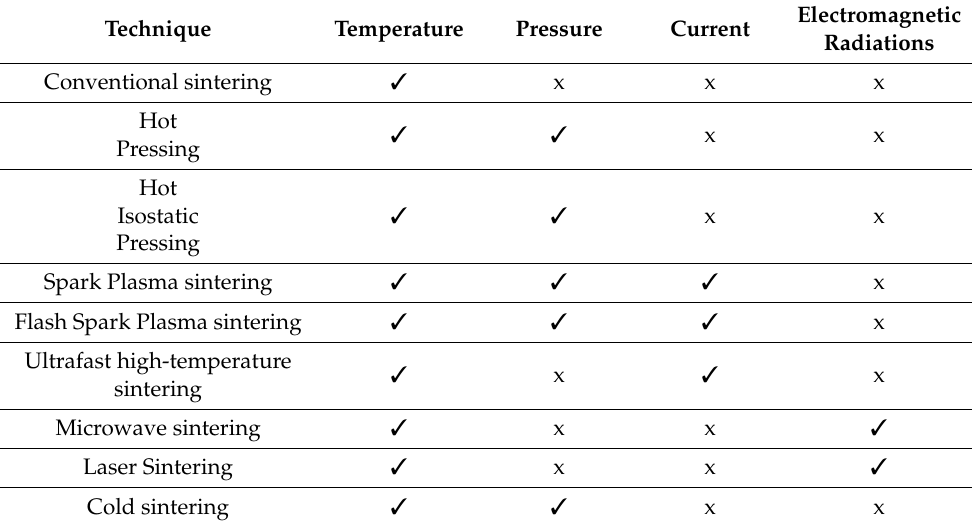
Table 3. Parameters of various sintering